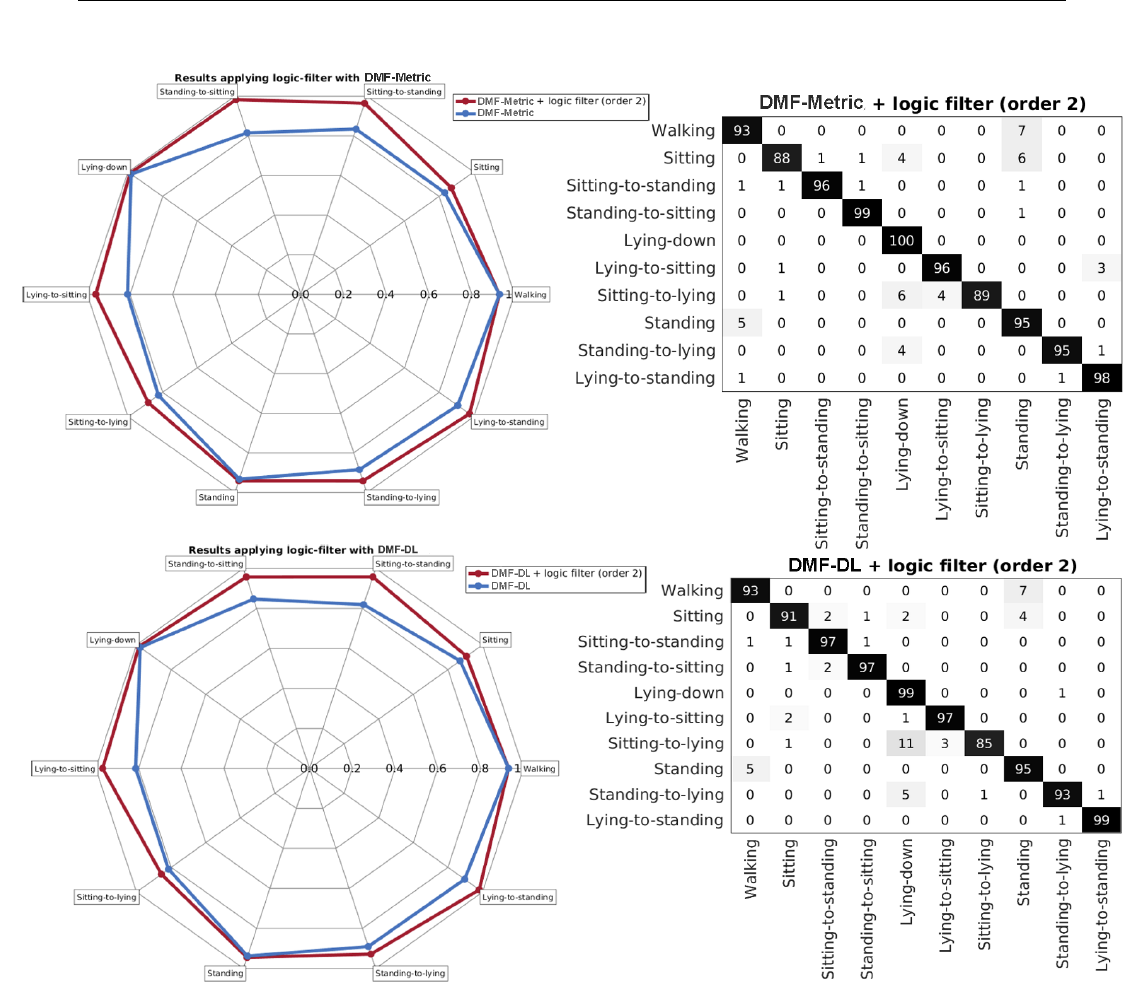
Figure 9. Performance results for applying the logical filter to DMF-Metric (upper) and DMF-DL (lower). The spider diagram shows the percentage of correctly classified input for each independent activity